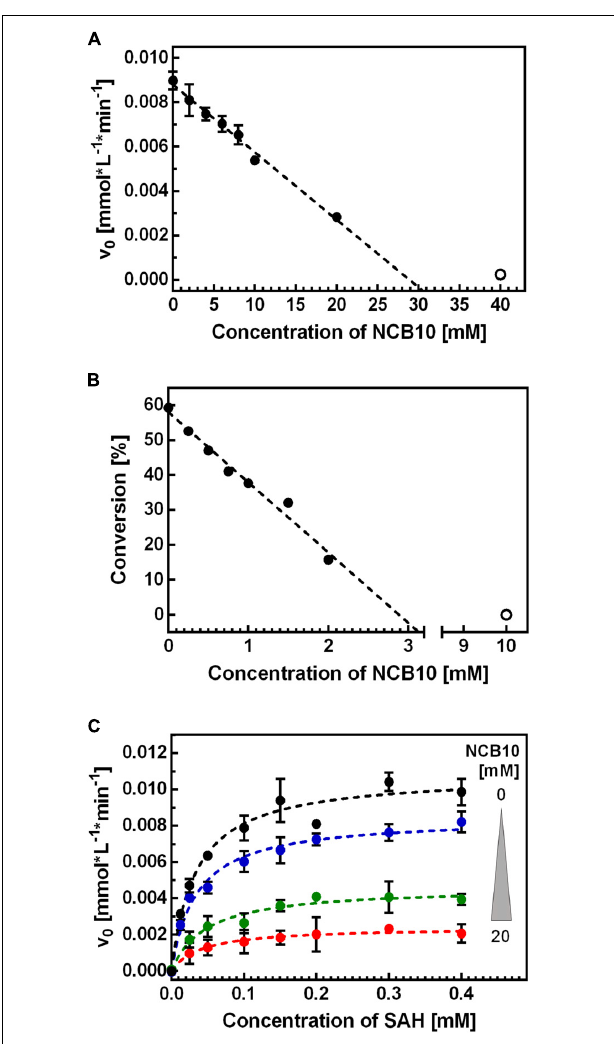
FIGURE 4 | Characterization of the inhibitory effect of NCB 10 on BeSAHase. The IC 50 of 10 was determined in the hydrolytic (A) and synthetic (B) direction. Only solid circles were considered for linear regression (dashed lines) which yielded IC 50 values of 14.4 ± 0.5 mM ( r 2 = 0.969) and 1.44 ± 0.04 mM ( r 2 = 0.974) for hydrolysis and synthesis, respectively. The hollow circles were excluded from the analysis, due to loss of linear relation in this range, but are displayed as an example of complete inhibition. (C) Michaelis–Menten kinetics of SAH hydrolysis were carried out with varying concentrations of 10 . Color-coding corresponds to the inhibitor concentration (black: 0 mM; blue: 5 mM; green: 15 mM; red: 20 mM). Dashed lines represent the Michaels–Menten fits. Displayed are average values and standard deviations of replicates ( A : n = 2; B,C : n =